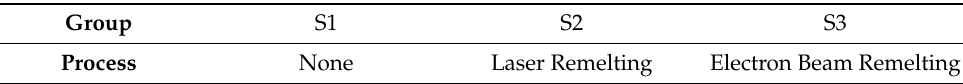
Table 1. Processing